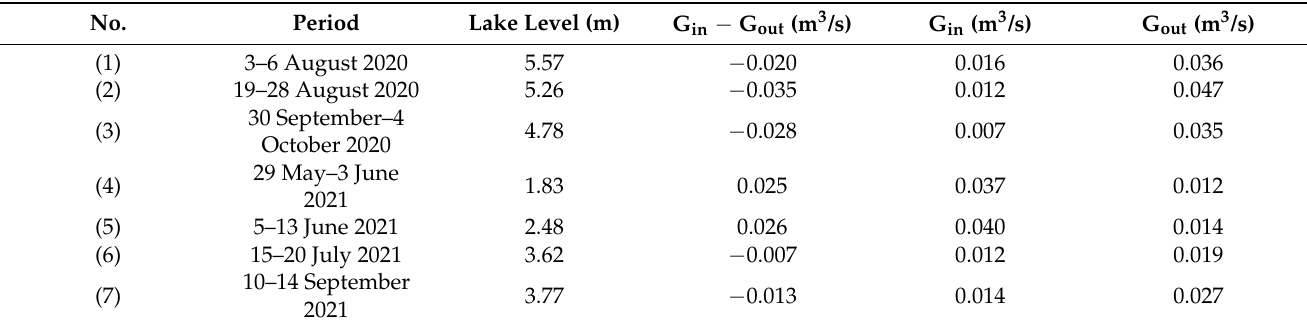
Table 1. Measured mean lake level, calculated net groundwater inflow (G in − G out ), and separated groundwater inflow G in and groundwater outflow G out for the non-rainfall periods of more than three days in 2020 and 2021.